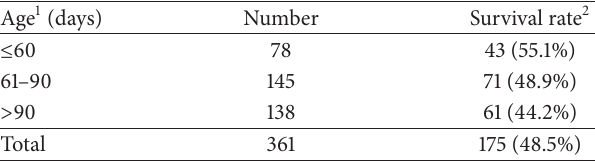
Table 1: Age and two-year survival with native